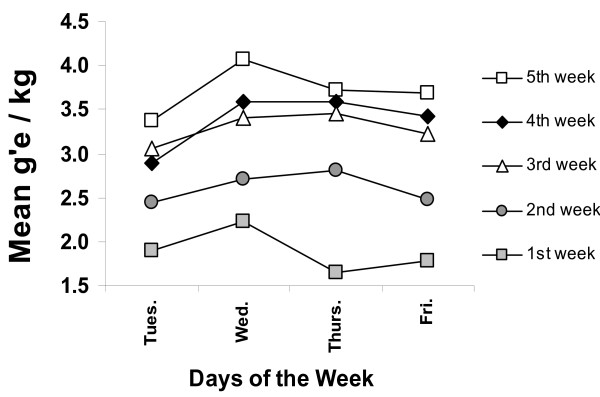
The progression of intake of ethanol across weeks. This figure depicts mean intake of ethanol as a function of week of presentation of the alcoholic beverage for the placebo-control group and the two groups getting the smallest doses of EV (an enlarged control group). Notice that there is a marked increase in intake from the 1st week to the 2nd and from the 2nd to the 3rd. Intakes tend to stabilize across the 3rd to 5th week. This pattern of increases is typical of rats presented palatable alcoholic beverage. Other data [e.g., 5] indicate that, without any further intervention, intakes increase only slightly beyond those of the 5th week of opportunity to take palatable alcoholic beverages.